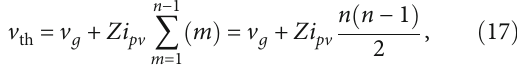
, 100 V/div); (b) current in residence 11 ( I 11